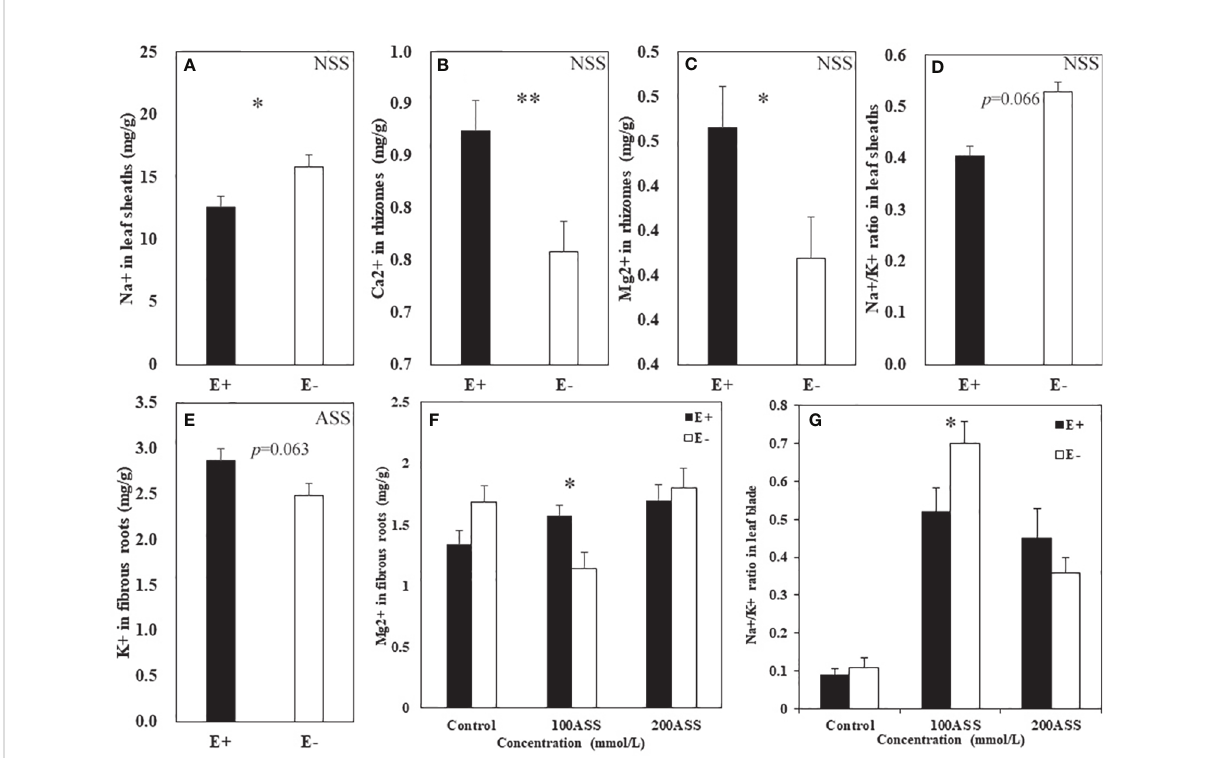
FIGURE 4 Na + , Ca 2+ , Mg 2+ , K + contents and Na + /K + ratio in shoots and roots of endophyte infected (E+) and uninfected (E − ) L. chinensis under neutral salt (A – D) and alkali salt (E – G) stresses. (A) Sheath Na + , (B) Rhizomes Ca 2+ , (C) Rhizomes Mg 2+ , (D) Sheath Na+/K+ ratio; (E) Fibrous root K + , (F) Fibrous root Mg 2+ , (G) Blade Na+/K+ ratio. Values are mean ± standard error. * and ** indicate signi fi cant difference at p < 0.05 and p < 0.01,